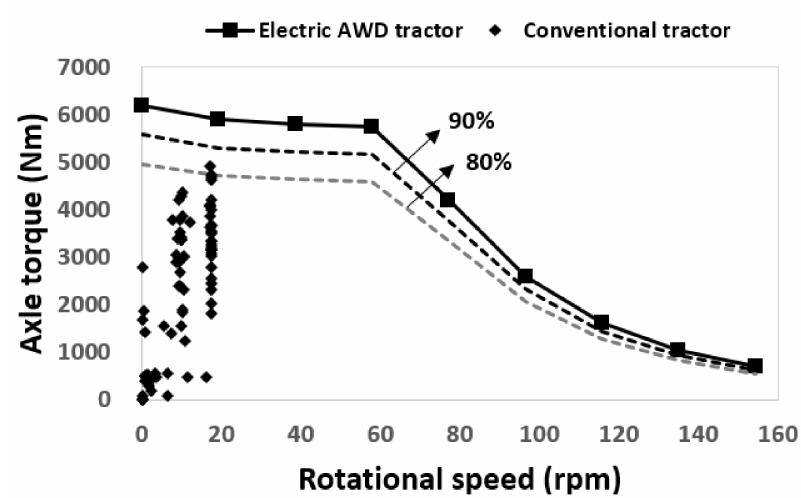
Figure 7. Analysis of agricultural work performance using workload of the conventional tractor and T–N curve of the electric motor with gear reduction